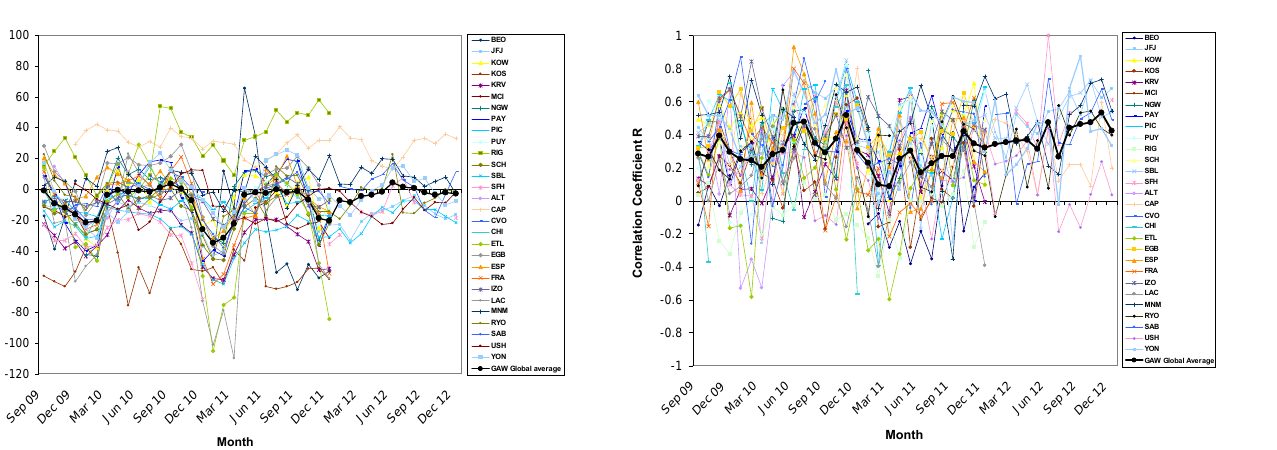
Figure 10. Modified normalised mean bias (MNMB) in % derived from the evaluation of the MACC_osuite with GAW CO surface observations over the period September 2009 to December 2012 (black line: global average of 29 GAW stations. Multi-coloured lines: individual station results; see legend to the right).